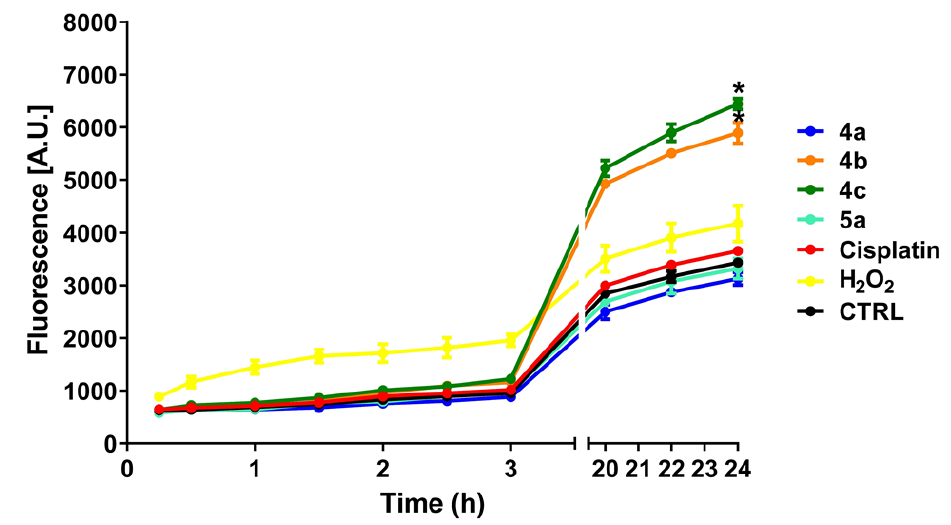
Figure 4. Fluorescence kinetics measurements of intracellular reactive oxygen species (ROS). A2780 cells incubated for 24 h with 10 µM of iron compounds at 37 °C.